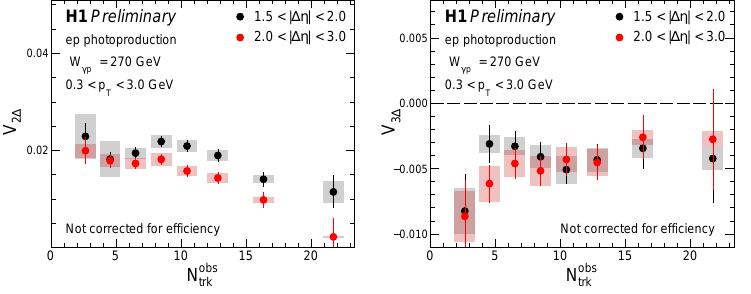
( 4 ) versus multiplicity in ep DIS at Figure 5: C 2 2-subevent and 3-subevent methods. This result is not corrected by efficiency.